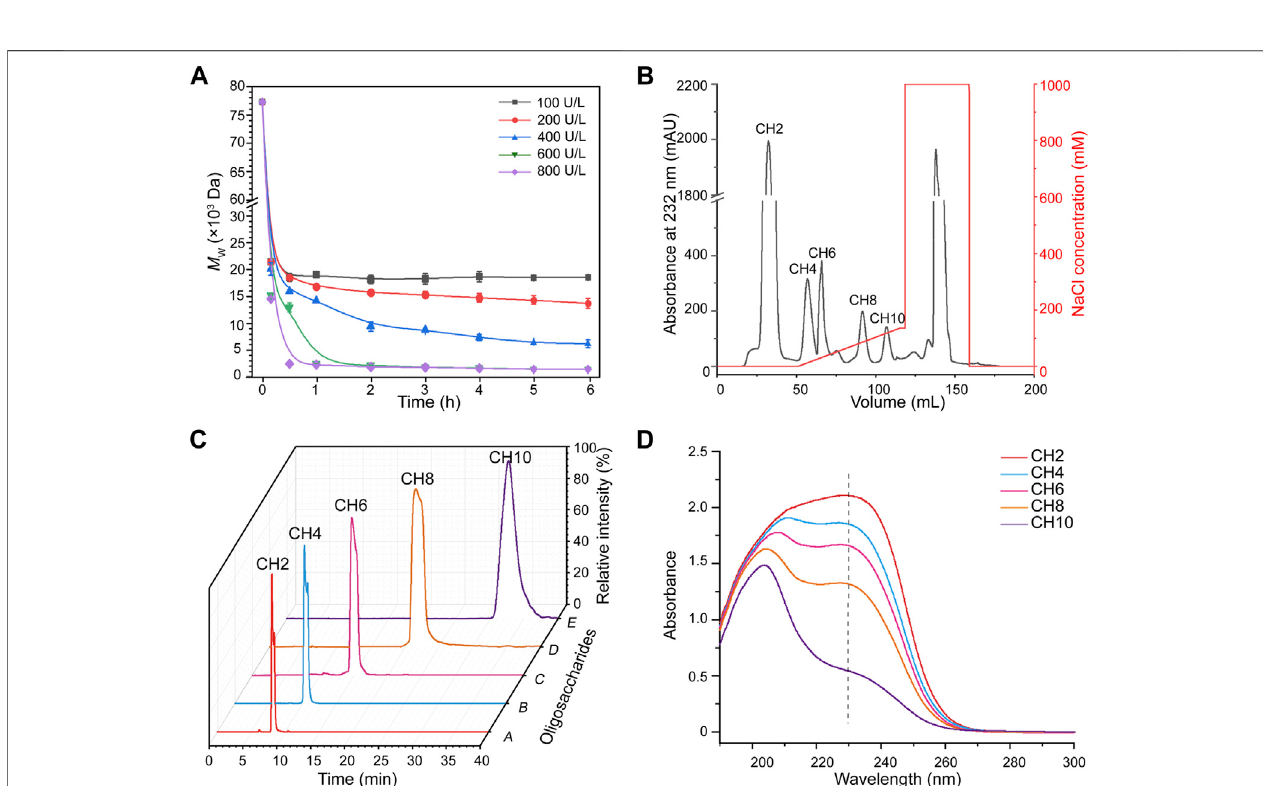
FIGURE 2 | Production and characterization of chondroitin oligosaccharides. (A) Time course of chondroitin depolymerization with different concentrations of csABC I. (B) Fraction of chondroitin oligosaccharides were linearly eluted with 0 – 140 mM NaCl from a Q HP column at a fl ow rate of 3 ml/min. (C) Purity analysis of the CH2, CH4, CH6, CH8, and CH10 via HPLC. (D) Ultraviolet absorption spectrum of chondroitin oligosaccharides. M w , molecular weight; CH2, disaccharide; CH4, tetrasaccharide; CH6, hexasaccharide; CH8, octasaccharide; CH10, decasaccharide. The data are expressed as the mean ± SD from three ( n = 3) biologically independent